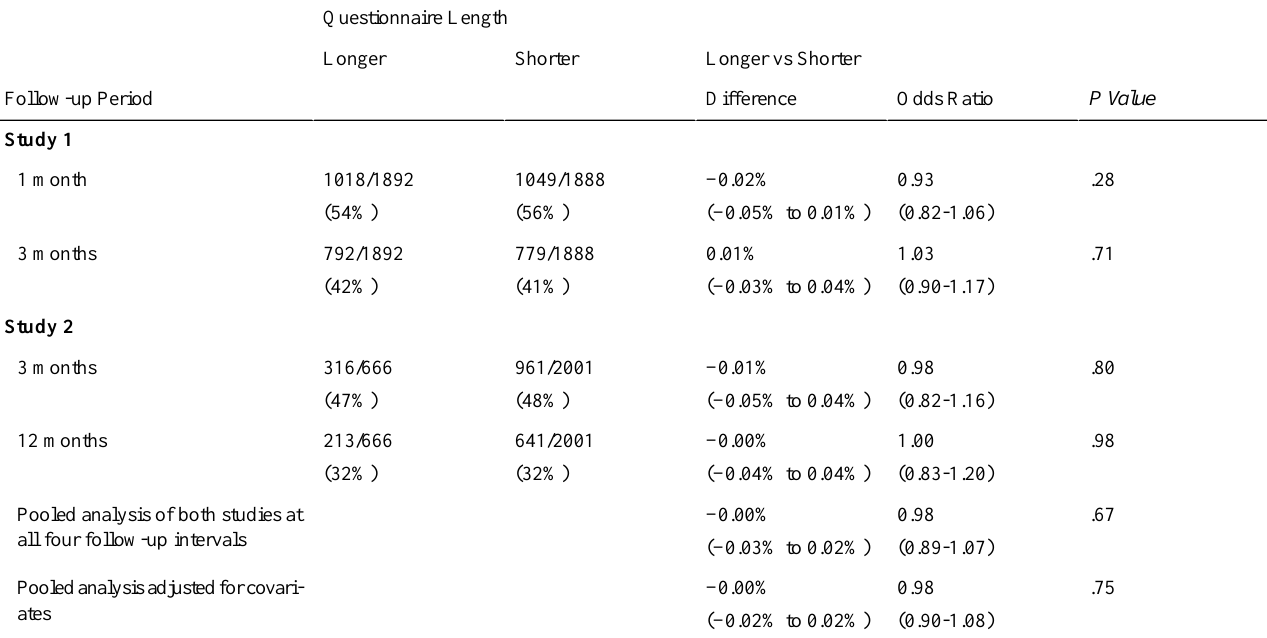
Table 3. Follow-up rates in those allocated to longer and shorter secondary outcome questionnaires Questionnaire Length